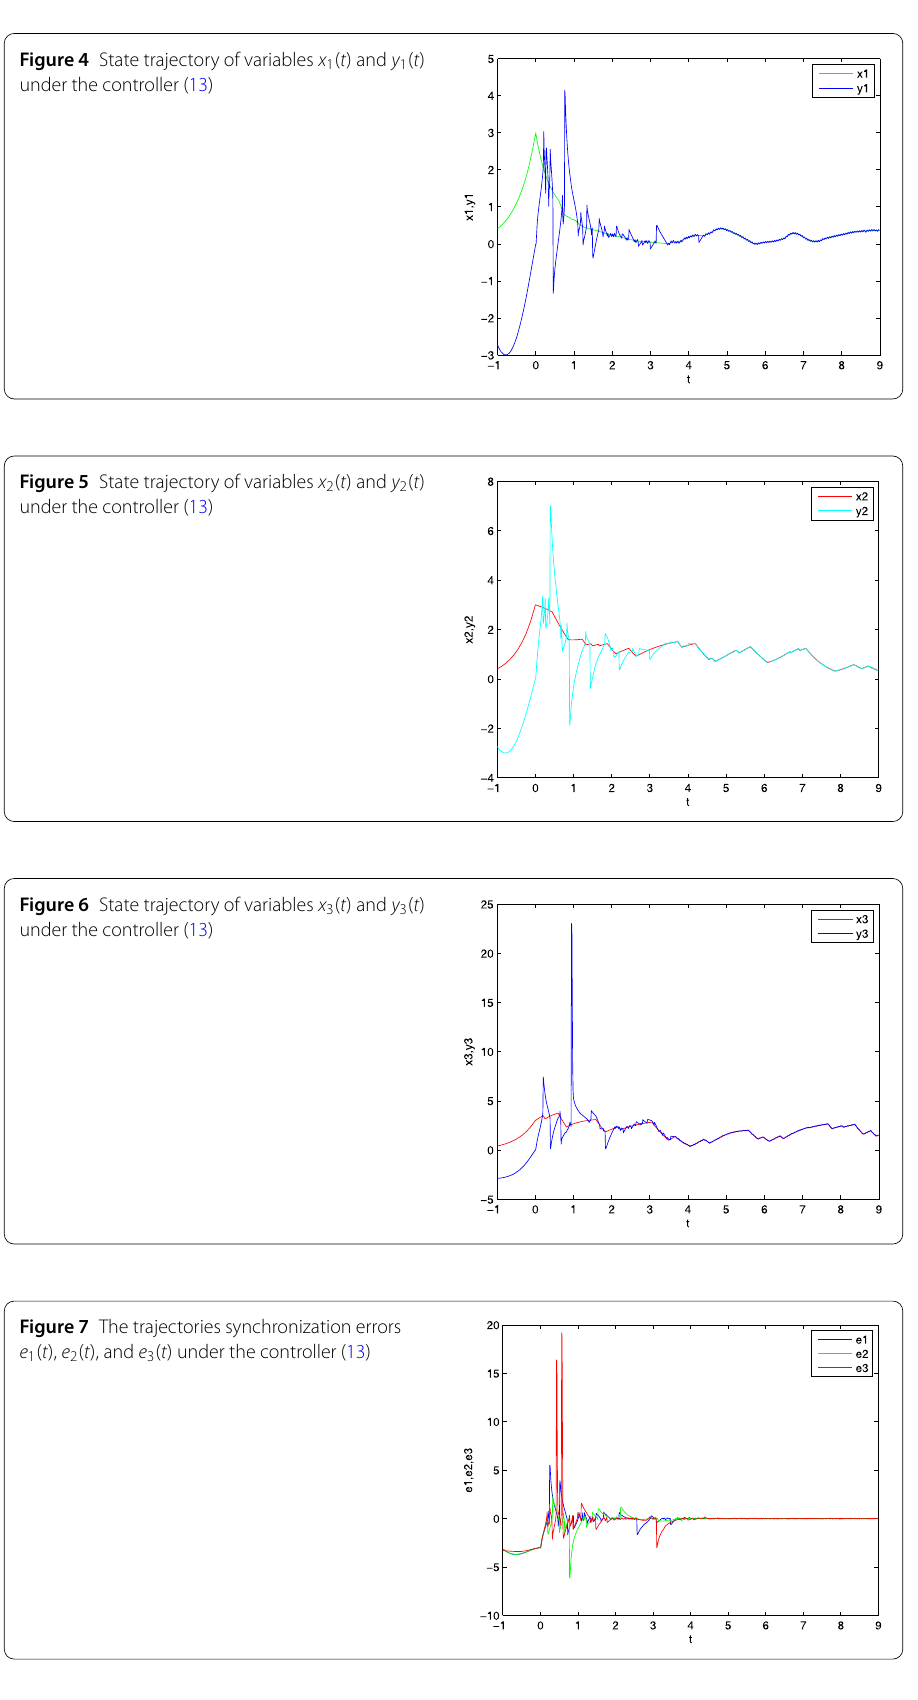
Figure 4 State trajectory of variables x 1 ( t ) and y 1 ( t ) under the controller (13)